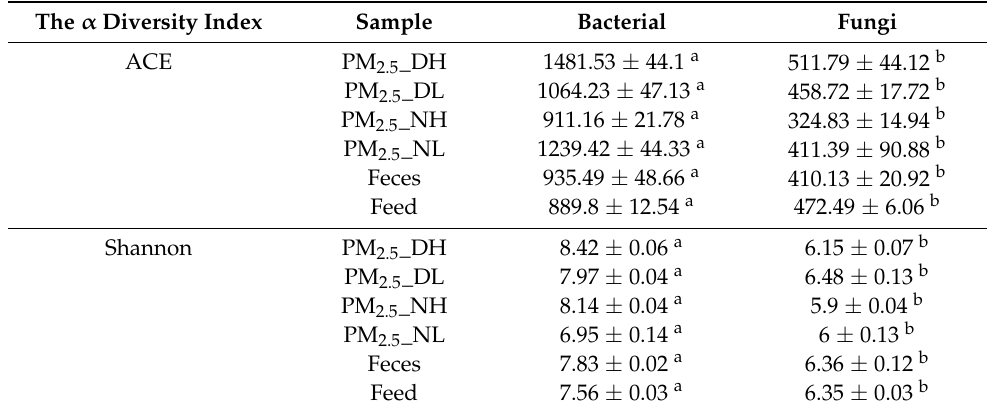
Table 3. α diversity index of different groups of